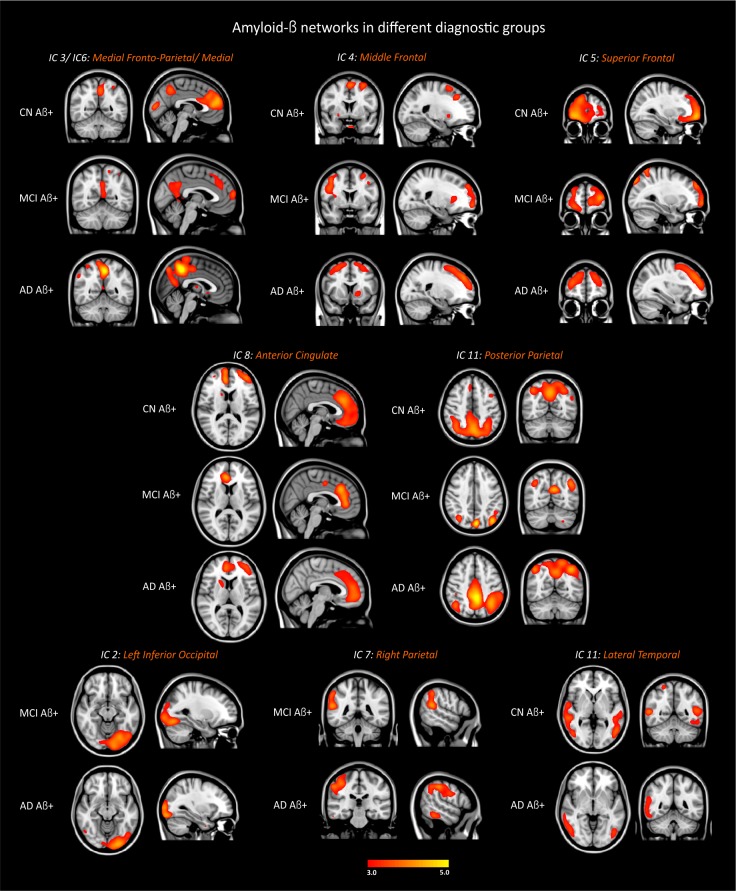
Amyloid-β networks in different groups.CN Aβ+, cognitively normal subjects with amyloid pathology (n = 34); MCI Aβ+, mild cognitive impairment patients with amyloid pathology (n = 21); AD Aβ+, patients with Alzheimer’s disease dementia with amyloid pathology (n = 36). The components were thresholded with a z-score >2.0.